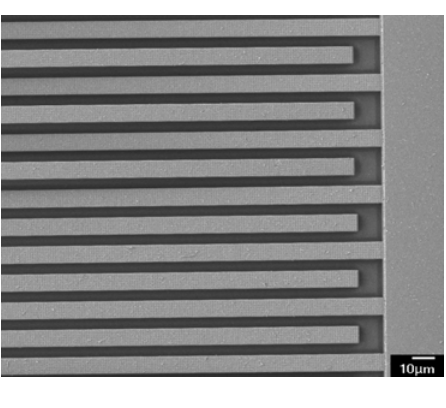
Figure 6. SEM image of the interdigitated electrodes for the humidity sensor.